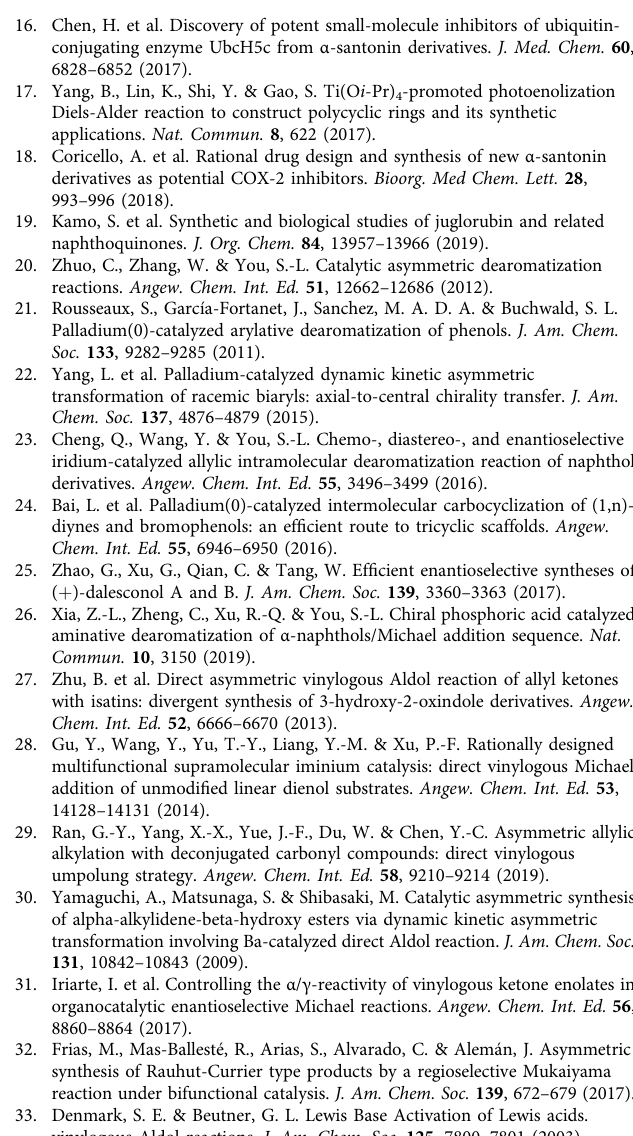
Fig. 9 Proposed mechanism. Possible reaction mechanism for the synergistic magnesium catalyst promoted